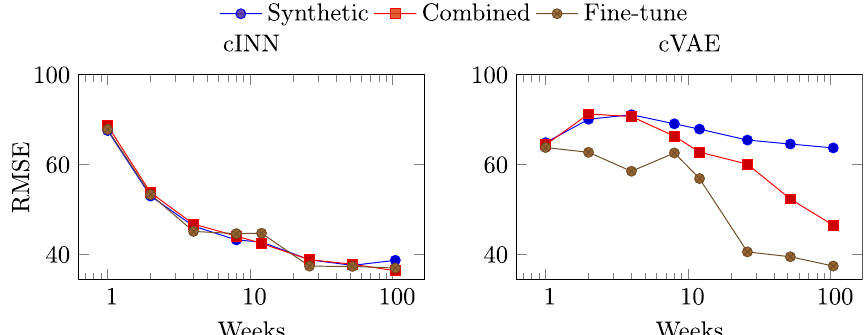
Fig. 6 The RMSE of the three data combination strategies and the two generative models given different amounts of available target data ( MT_124 ). The used forecasting model is the FCN and the LSFE is applied with the around seed noise sampling strategy for the cINN and the shift seed noise sampling strategy for